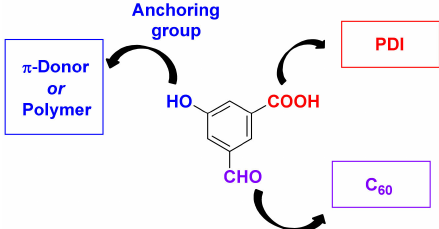
Figure 2. Presentation of the 3-formyl-5-hydroxybenzoic acid platform for incorporating C 60 using Prato reaction, PDI moiety by esterification and the free phenol anchoring group for the versatile attachment of an electron donor or a polymerizable